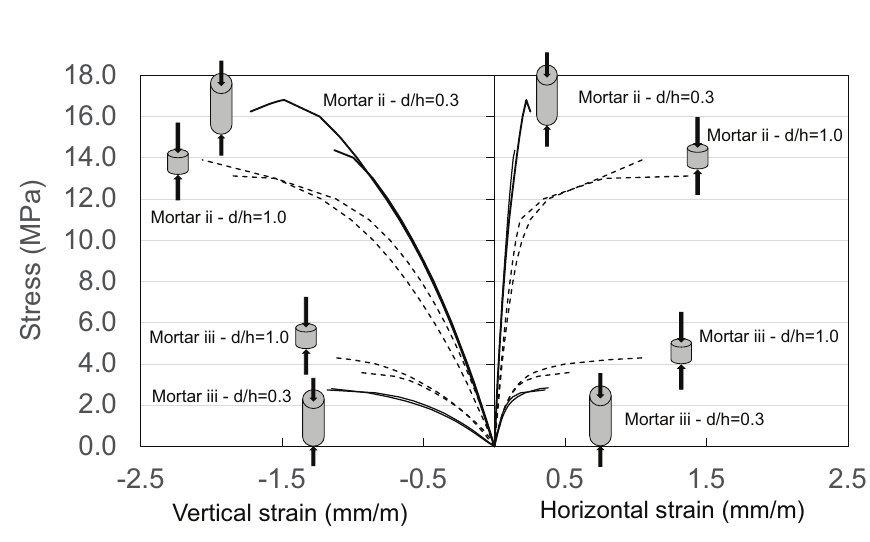
Mortar stress-strain response